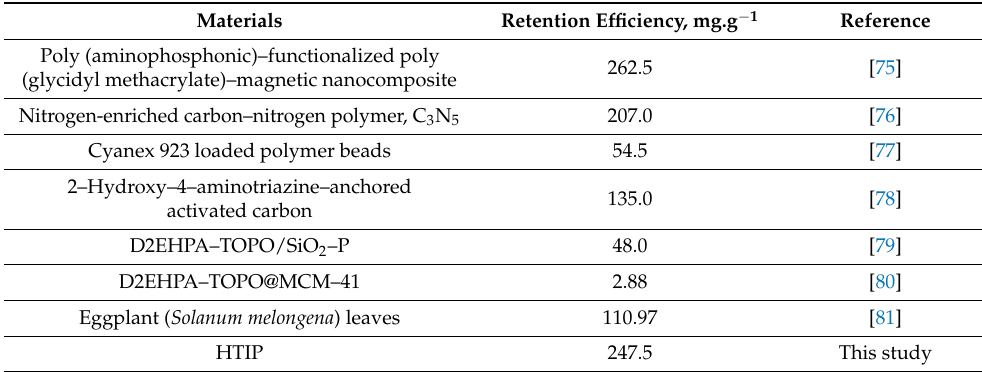
Figure 9. ( a ) The influence of HTIP dose on the retention of uranium; ( b ) the regression analysis of U(VI) ion extraction by HTIP at different concentrations. (U(VI) conc.: 0.42 × 10 − 4 mol/L, pH 3.0, Time: 30 min, A/O 1:1, T: 25 °C). Table 2. Comparison of retention efficiency of different